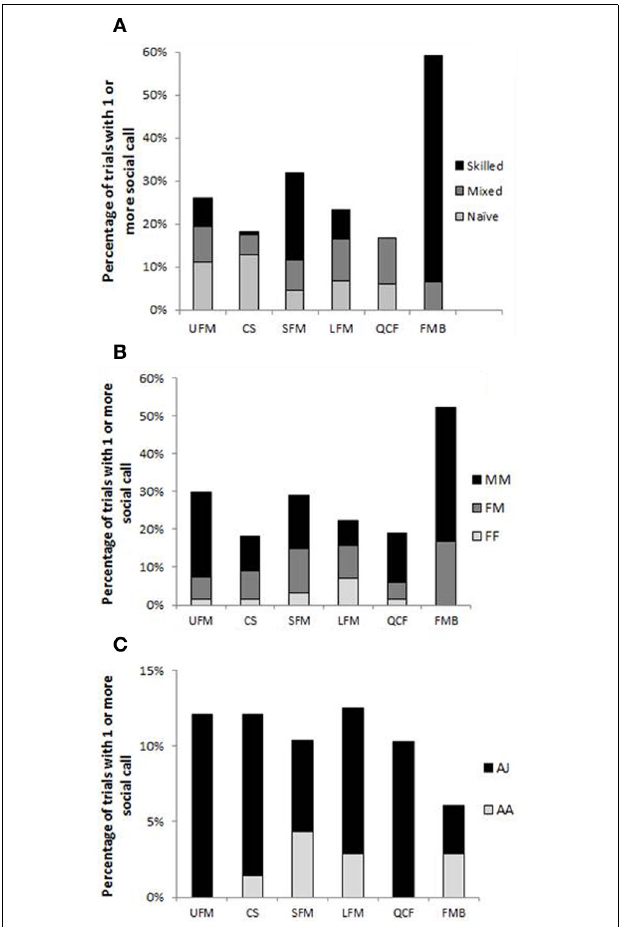
FIGURE 3 | Percentage of trials from each trial type (A), sex combination (B), and age combination (C) containing at least one instance of social calls of each type. See Table 3 for related statistics. Because all skilled trials ( N = 152) contained only adults, skilled trials are excluded from panel (C) . Mixed ( N = 170) and naïve ( N = 181) trials are mostly from adult–juvenile pairs, which is why calls from this age combination appear so much more common than social calls from adult–adult pairs in the figure. MM, male–male ( N = 121); FM, female–male ( N = 256); FF, female–female ( N = 126); AJ, adult–juvenile ( N = 282); and AA, adult–adult ( N = 69 naïve and mixed trials) trial types. Call type abbreviations: UFM, upward frequency-modulated;CS, chevron-shaped; SFM, short frequency-modulated;LFM, long frequency-modulated;QCF,